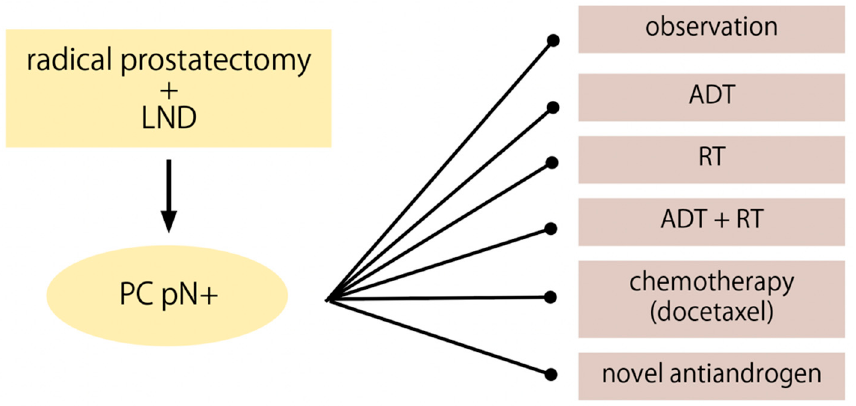
Figure 2. Therapeutic strategies in the management of patients with prostate cancer and lymph node metastases after radical prostatectomy (pN+).